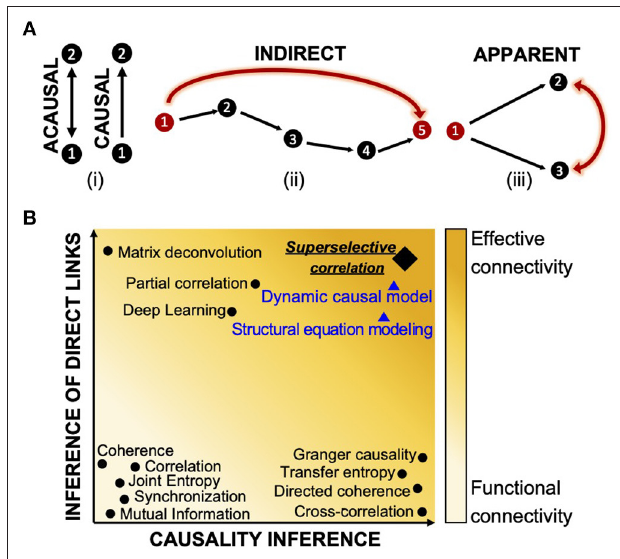
FIGURE 1 | Definition of functional and effective connectivity. (A) Classification of causal (directional link), indirect (multi-neurons pathway), and apparent (functional coupling due to common input) connectivity. (B) Classification of most common connectivity inference methods in terms of causality and detection of direct links. On the x -axes, the graph shows a scale of causality that refers to the ability of a given connectivity method to infer or not the directionality of the functional connections between neurons. On the y -axes, the graph visually quantifies the capabilities of one approach to detect direct links between neurons by identifying and discarding multi-neurons connections and apparent ones. Indicators that are acausal and do not infer direct links can only report about functional connectivity (light yellow); indicators which contain information about direction of interaction and direct neuron-to-neuron communication are close to the inference of effective connectivity (orange color). Most common model-free techniques are indicated with black dots. Model-based methods are reported with blue triangles and their ability to infer effective connectivity is negatively weighted by the impossibility to test their performances. The super-selective correlation approach we propose is reported in black like the other model-free methods; a diamond signal is used to emphasize the fact that, although being model-free, it aims at inferring effective connections. The graph visually summarizes results of comparisons between connectivity methods from review papers ( Garofalo et al., 2009; Wang et al., 2014; de Abril et al., 2018) and do not contain precise quantitative information about the